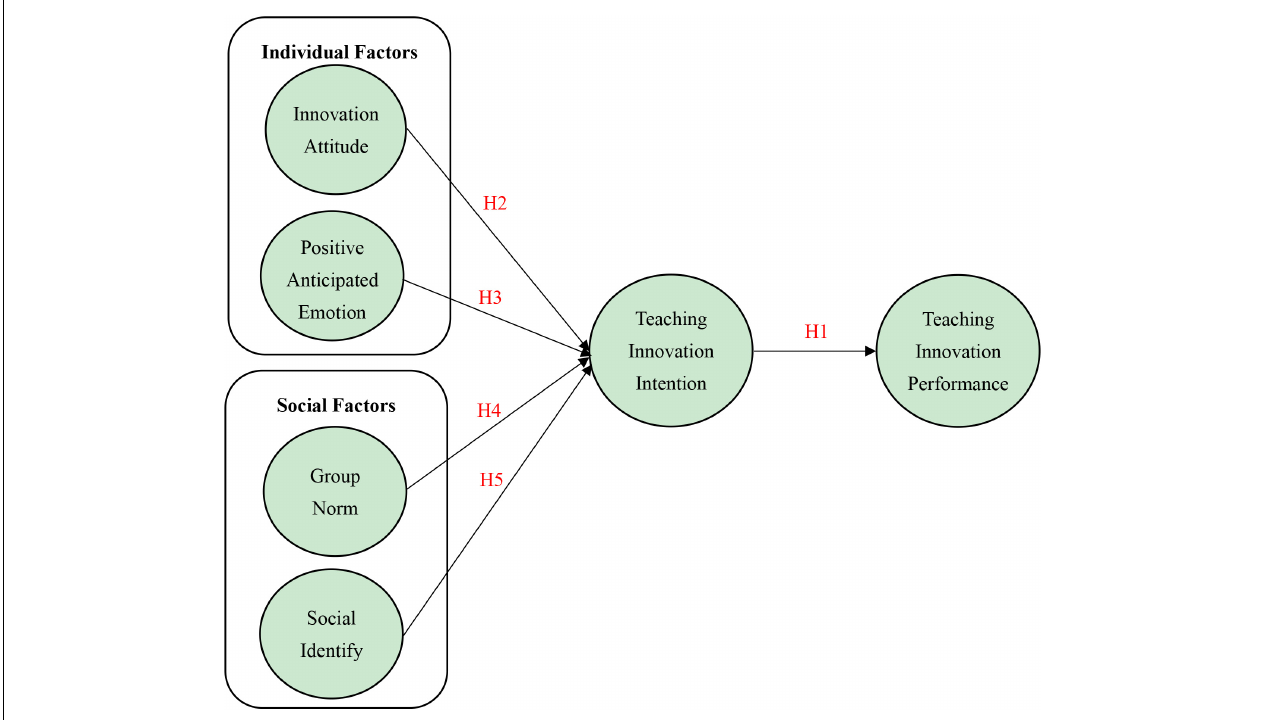
FIGURE 1 | Research